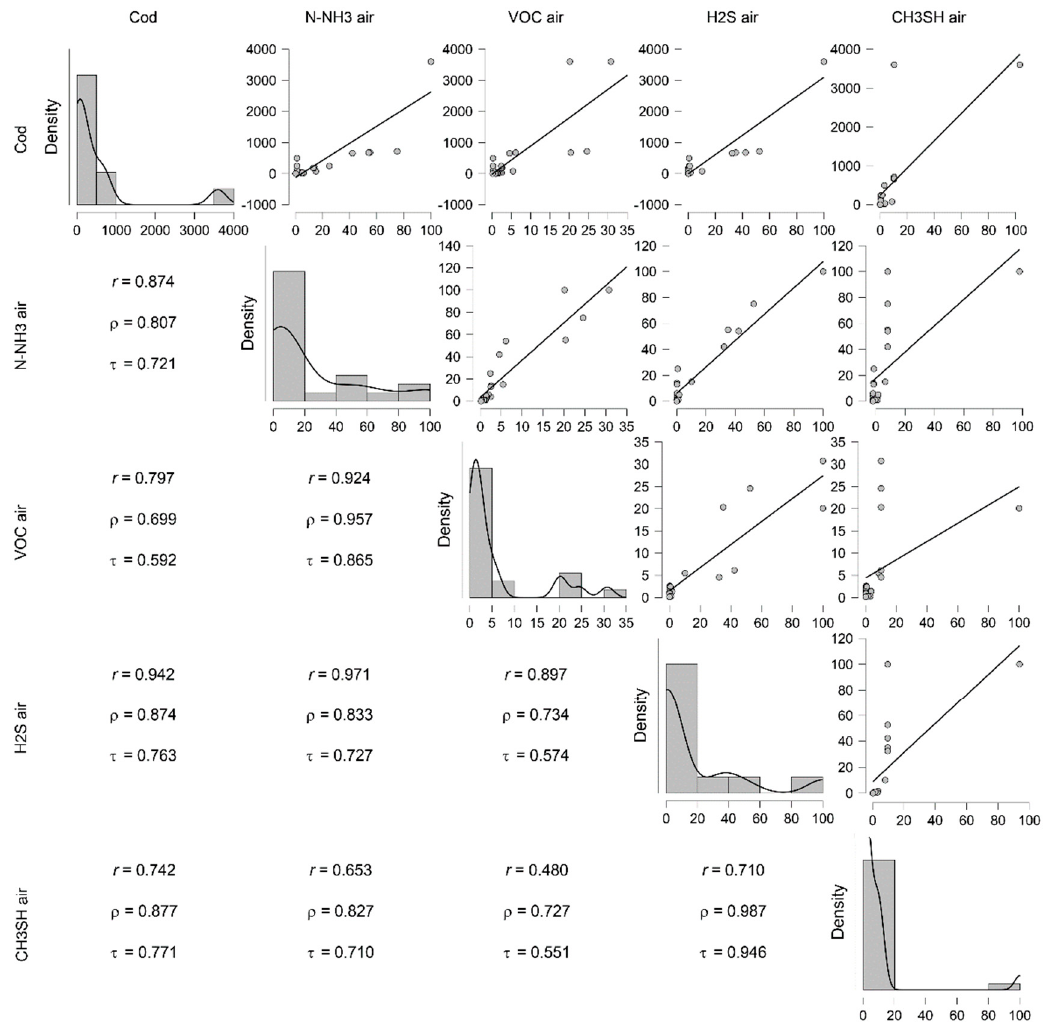
Figure 1. Correlation plot of air components, with Pearson’s r, Spearman’s rho and Kendall Tau B